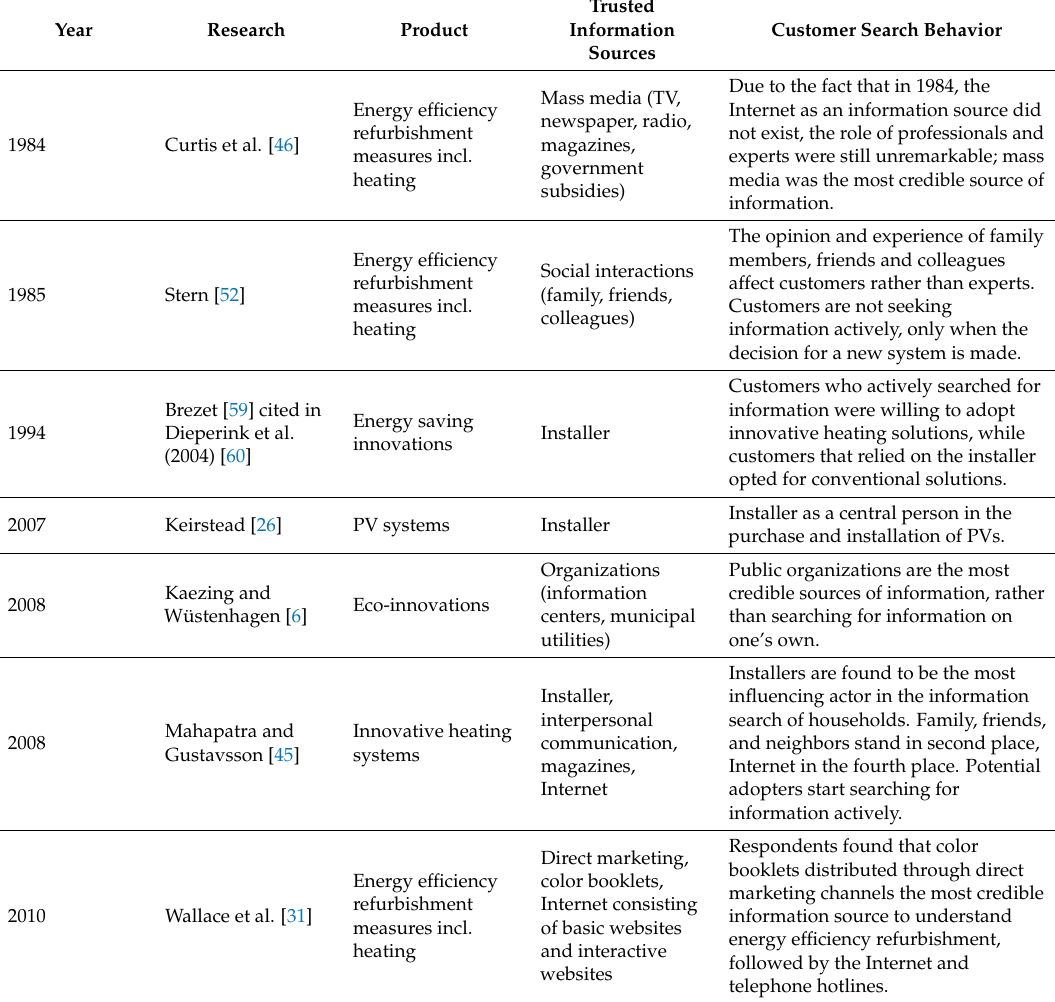
Table 2. The influencing role of social environment and trusted information sources. WOM: word of